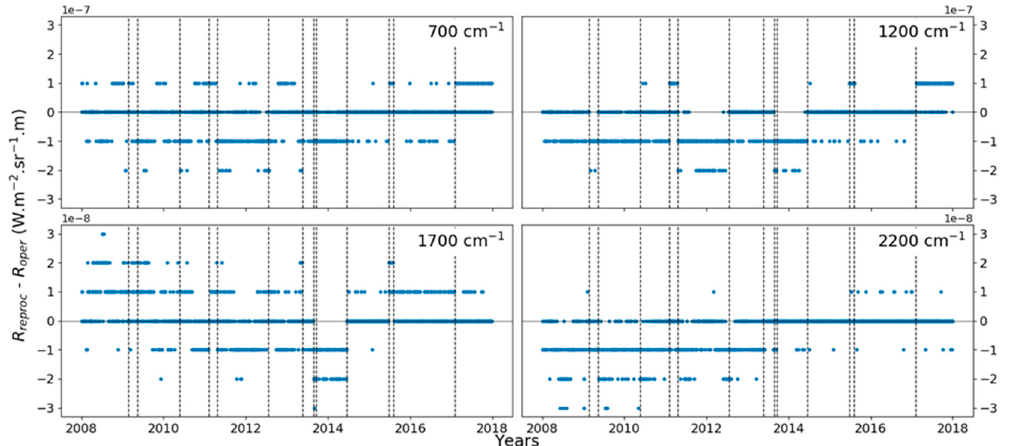
Figure 2. Example of differences between the reprocessed and operational radiance values in Greenland at 700, 1200, 1700, and 2200 cm -1 for the eighth FoR, as an example. Vertical dashed lines correspond to L1C updates (see Table 1).